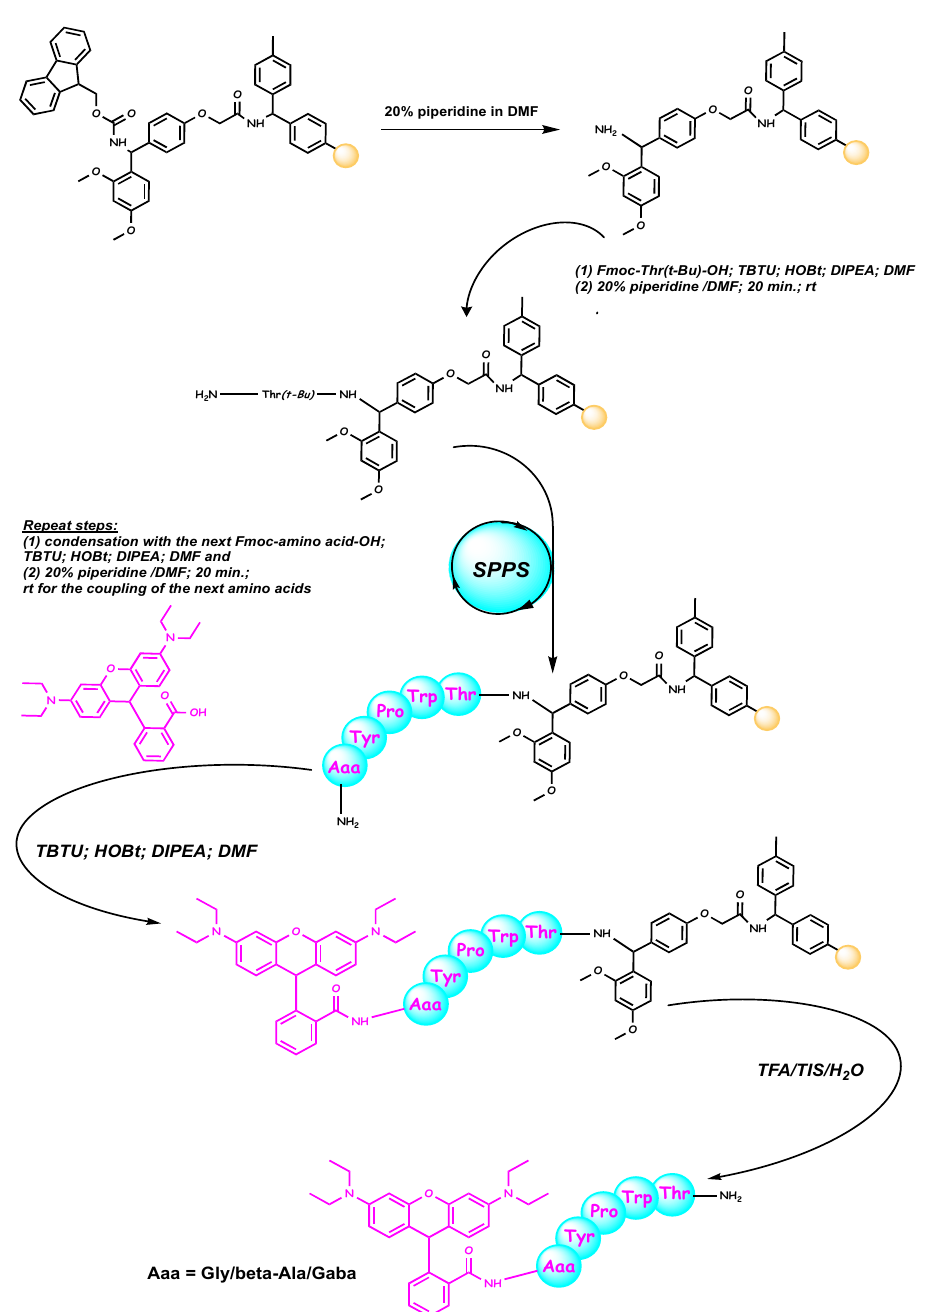
Figure 1. Schematic representation of the solid phase synthesis of the new hybrid peptides.